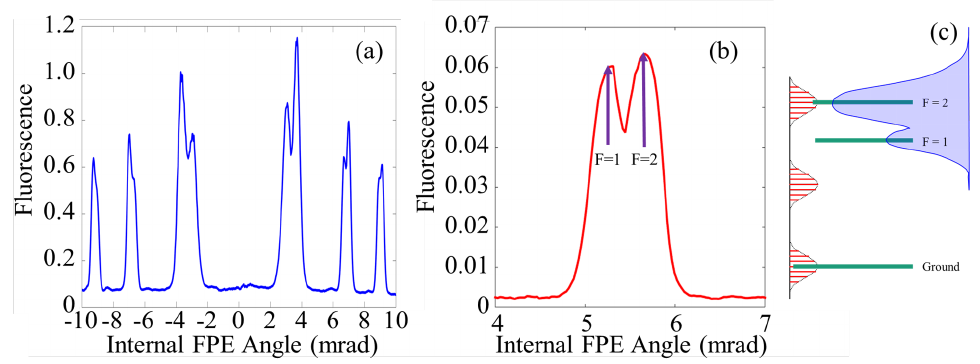
Figure 10. ( a ) Plot of the fluorescence intensity as the etalon’s angle is tuned 20 mrad. At 0 mrad, the etalon is in normal incidence to the larger cavity, and therefore, prevents mode-locking from occurring. It is not abnormal to see some fluorescence in this location, but that fluorescence is related to the instability of the laser in this region. This region of instability is typically ± 2 mrad from 0 mrad. ( b ) Zooming into the first fluorescent order of ( a ). The two maxima are labeled as F = 2 and F = 1 with the associated measured values for the angles at which they occur. These values are picked as the rough center of the average envelope of the peaks and the labels are the predicted state each maxima is associated with. ( c ) A cartoon depiction of an rf comb aligned to the energy levels of the D1 line of 87 Rb.